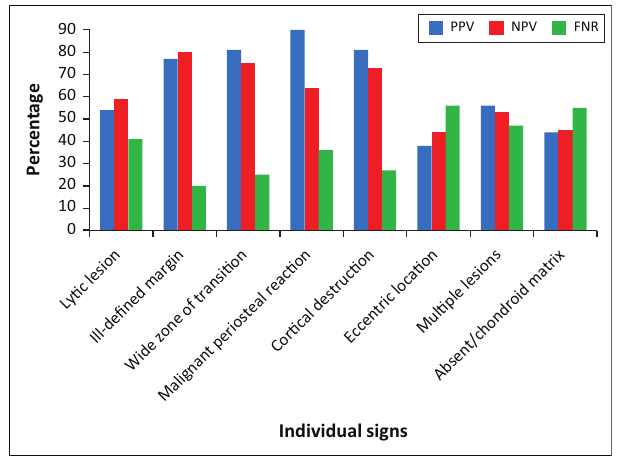
FIGURE 2: Positive and negative predictive values of individual signs used.